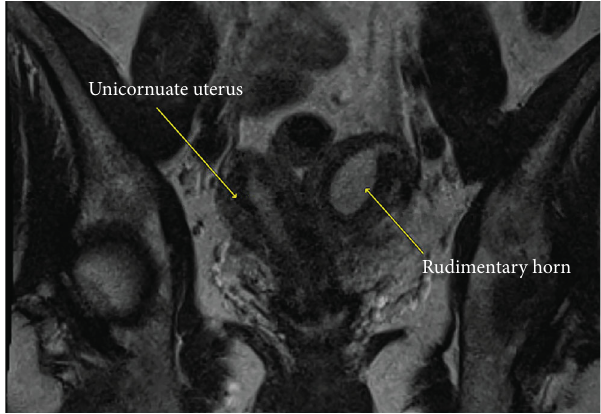
Figure 4: MRI of communicating and noncommunicating